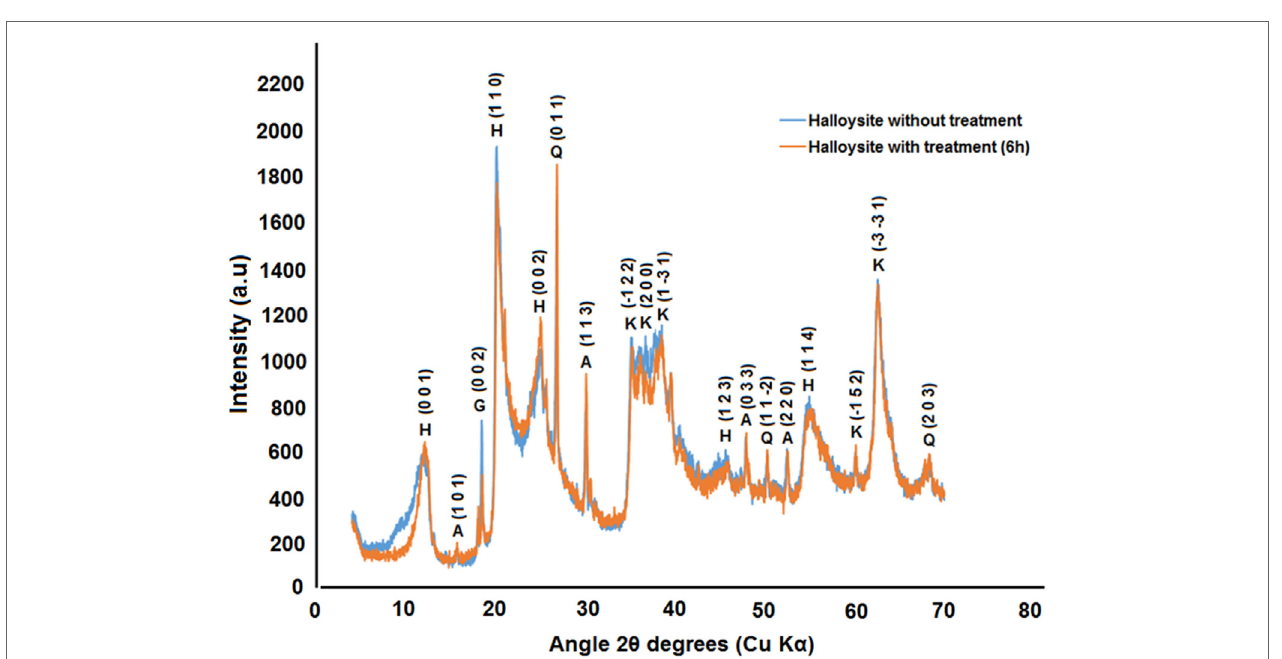
FigUre 2 | X-ray diffraction diffractograms of powdered samples for the halloysite without treatment and with treatment in 2 mol/l sulfuric acid during 6 h . H, halloysite; A, alunite; Q, quartz; K, kaolinite; G,